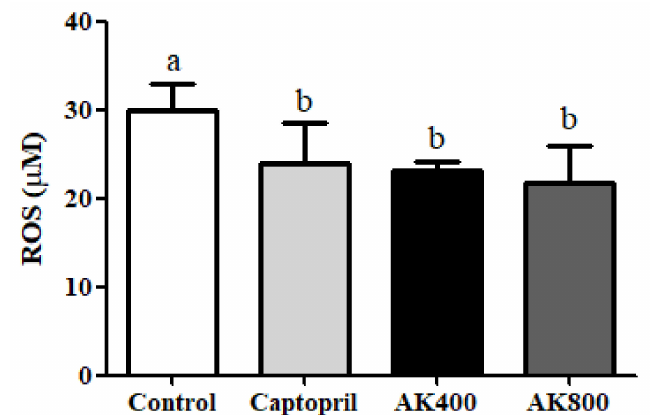
Figure 2. Reactive oxygen species (ROS) generation in the SHR brains. The groups were the control (distilled water), captopril (20 mg / kg body weight), AK3K400 (400 mg / kg body weight), and AK3K800 (800 mg / kg body weight). Data are presented as the mean ± SD. a-b Di ff erent letters indicate statistically significant di ff erences ( p < 0.05) in the di ff erent